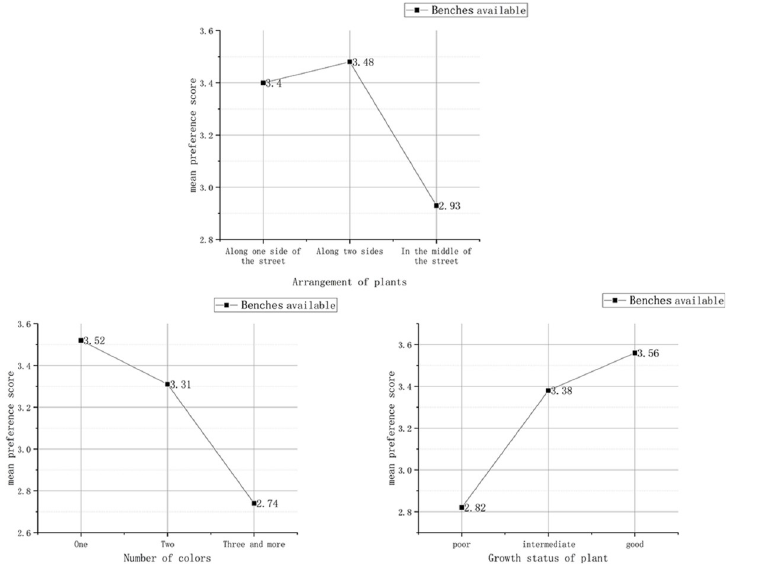
Fig 5. Preference evaluation under the influence of benches and plant factors I.